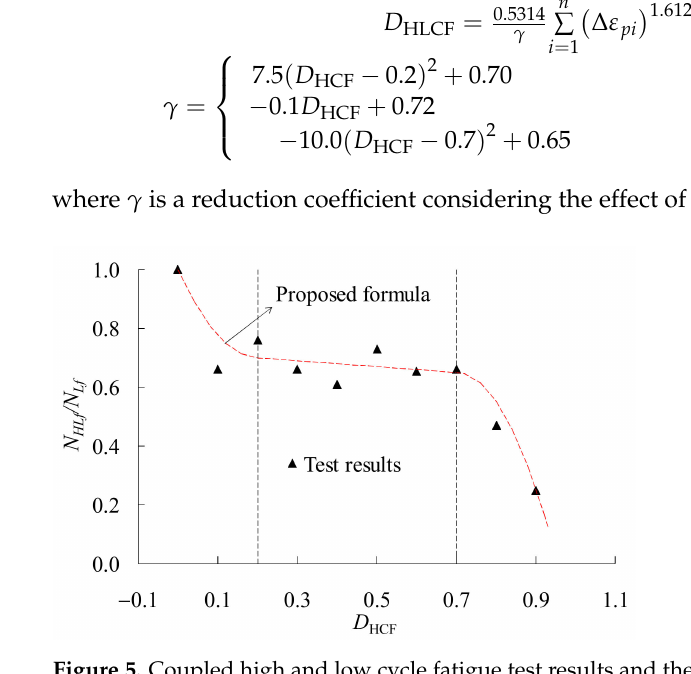
Figure 5. Coupled high and low cycle fatigue test results and the proposed